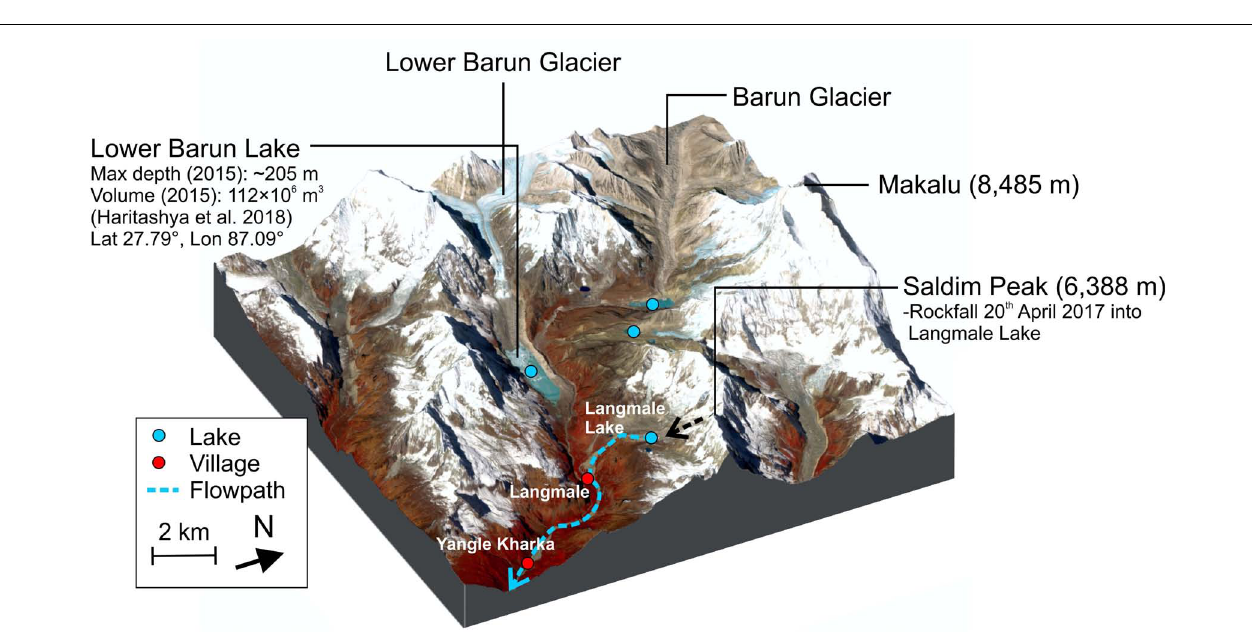
FIGURE 7 | Location of the Langmale outburst flood. Background is a Sentinel-2 image composite of bands NIR, red, blue (19 November 2017).